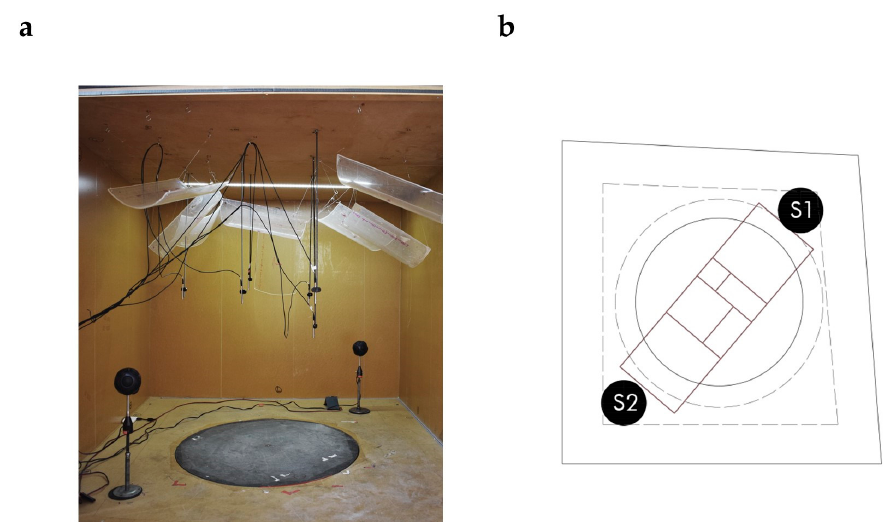
Figure 10. ( a ) Empty small-scale reverberation room; ( b ) example of the configuration of the SSRR floor plan, with source 1 (S1) on the right and source 2 (S2) on the left.